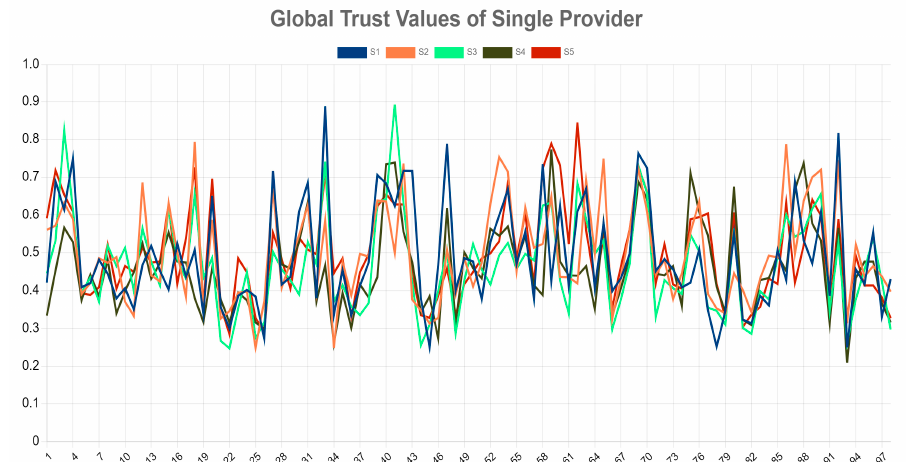
Figure 12. Global Trust Values (Tglobal) for 5 different services provided by SP1.